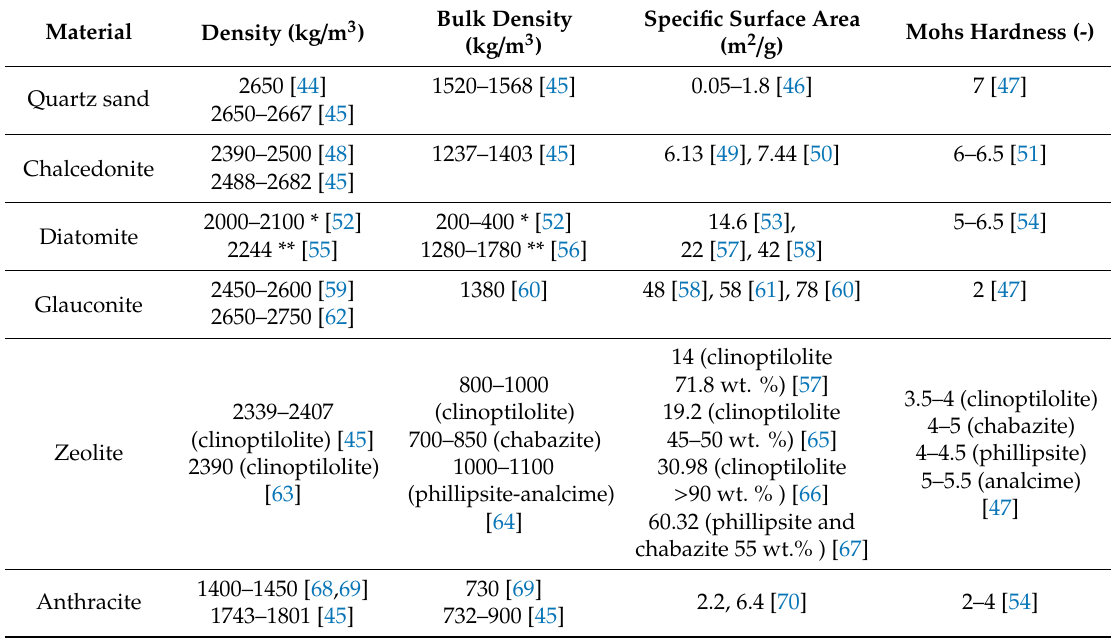
Table 1. Properties of mineral materials using as filter media for water